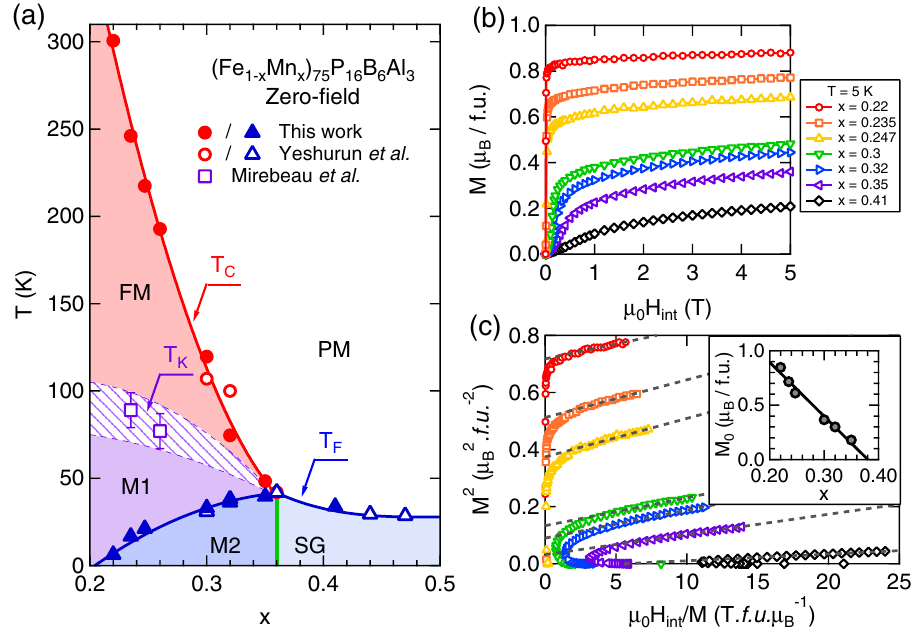
Figure 1. Phase diagram and magnetization of a-Fe 1 − x Mn x —( a ) Zero-field magnetic phase diagram of a-Fe 1 − x Mn x inferred from magnetic ac-susceptibility. For 0.2 (cid:31) x (cid:31) x C , cooling from the high-temperature FM state leads to a sequence of two mixed states: M1, involving the freezing of transverse spin components 18 and M2, where replica symmetry is spontaneously broken (i.e., an analog of the SG state). Above x = x C ≈ 0.36 , the ferromagnetic (FM) phase is suppressed and replaced with a “canonical” spin-glass (SG) state at low temperature. Open symbols are data from Mirebeau et al. 13,14 and Yeshurun et al. 15 which are added to our results for T C and T F for the sake of completeness. The green vertical line indicates a putatively vertical critical line between the RSG (M2 phase) and SG regimes 1 . ( b ) Low-temperature magnetization curves of a-Fe 1 − x Mn x . ( c ) Arrot plots computed from the data of panel ( b ). Dashed lines are linear fits to the high-field data. Inset shows the x -dependence of the spontaneous magnetization M 0 = M ( µ 0 H int → 0 )